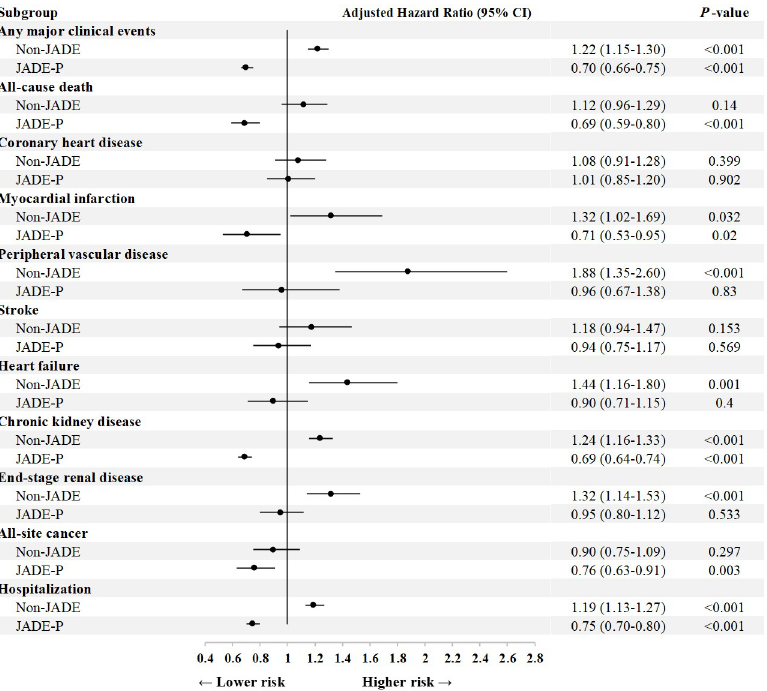
Fig 3. Forest plot showing the independent risk associations of incident clinical events and hospitalization in the non-JADE and JADE-P groups, compared with the JADE group. The non-JADE group underwent publicly funded evaluation. The JADE group received publicly funded evaluation with JADE report and group education. The JADE-P group received self-paid evaluation with JADE report, personalized empowerment, and annual telephone reminder for engagement. Any major clinical event was defined as the first occurrence of either CHD, PVD, stroke, heart failure, CKD, ESRD, all-site cancer, or all-cause death. MI was defined as either acute MI or coronary artery bypass graft surgery. Hospitalization was calculated for patients with at least an overnight stay. We performed multivariable Cox proportional hazards models, adjusting for age, sex, diabetes duration, education status, self-care index, smoking status, HbA 1c , systolic BP, LDL cholesterol, HDL cholesterol, triglyceride, waist circumference, urinary ACR, eGFR, medication usage (oral glucose-lowering agents, insulin, RASi, and statins), diabetic retinopathy, sensory neuropathy, and comorbidities documented at baseline. Self-care index was defined as any 2 of the following 3 self-care activities, namely self-monitoring of blood glucose at least weekly, adherence to balanced diet, and physical activity at least thrice weekly. ACR, albumin:creatinine ratio; BP, blood pressure; CHD, coronary heart disease; CKD, chronic kidney disease; eGFR, estimated glomerular filtration rate; ESRD, end-stage renal disease; HbA 1c , hemoglobin A 1c ; HDL, high-density lipoprotein; JADE, Joint Asia Diabetes Evaluation; JADE-P, JADE-Personalized; LDL, low-density lipoprotein; MI, myocardial infarction; PVD, peripheral vascular disease; RASi, renin-angiotensin system